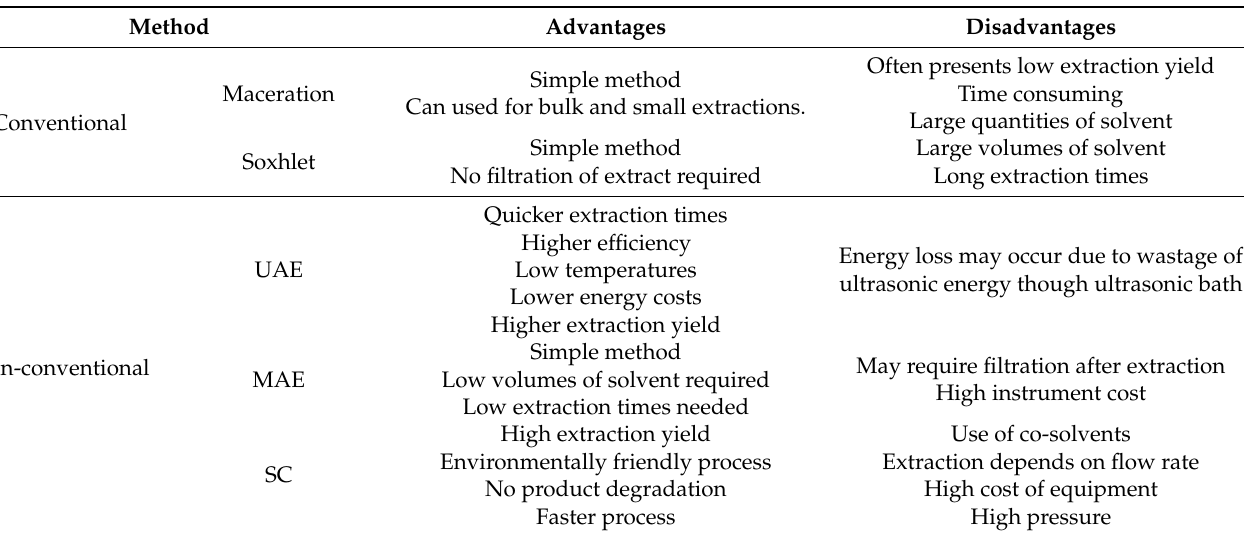
Table 2. Summary of the main advantages and disadvantages of conventional and non-conventional extraction methods (adapted from